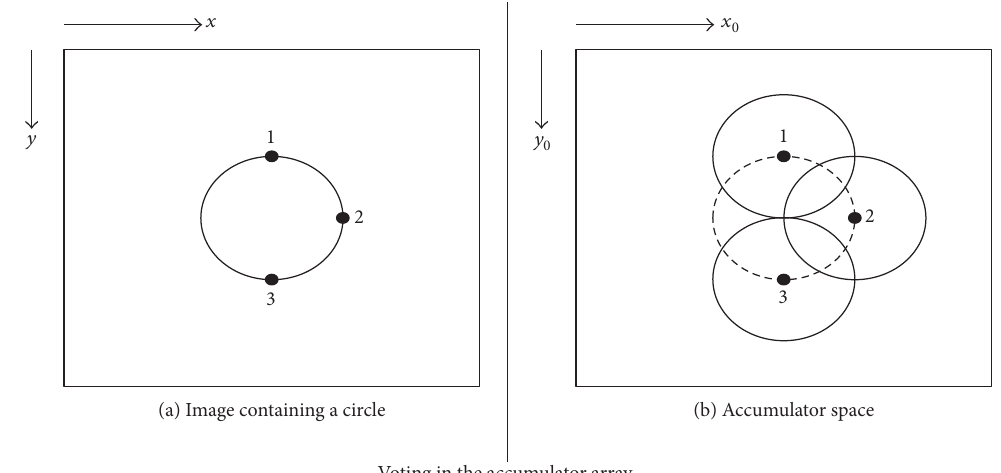
Figure 5: (a) Image containing circle. (b) Accumulator